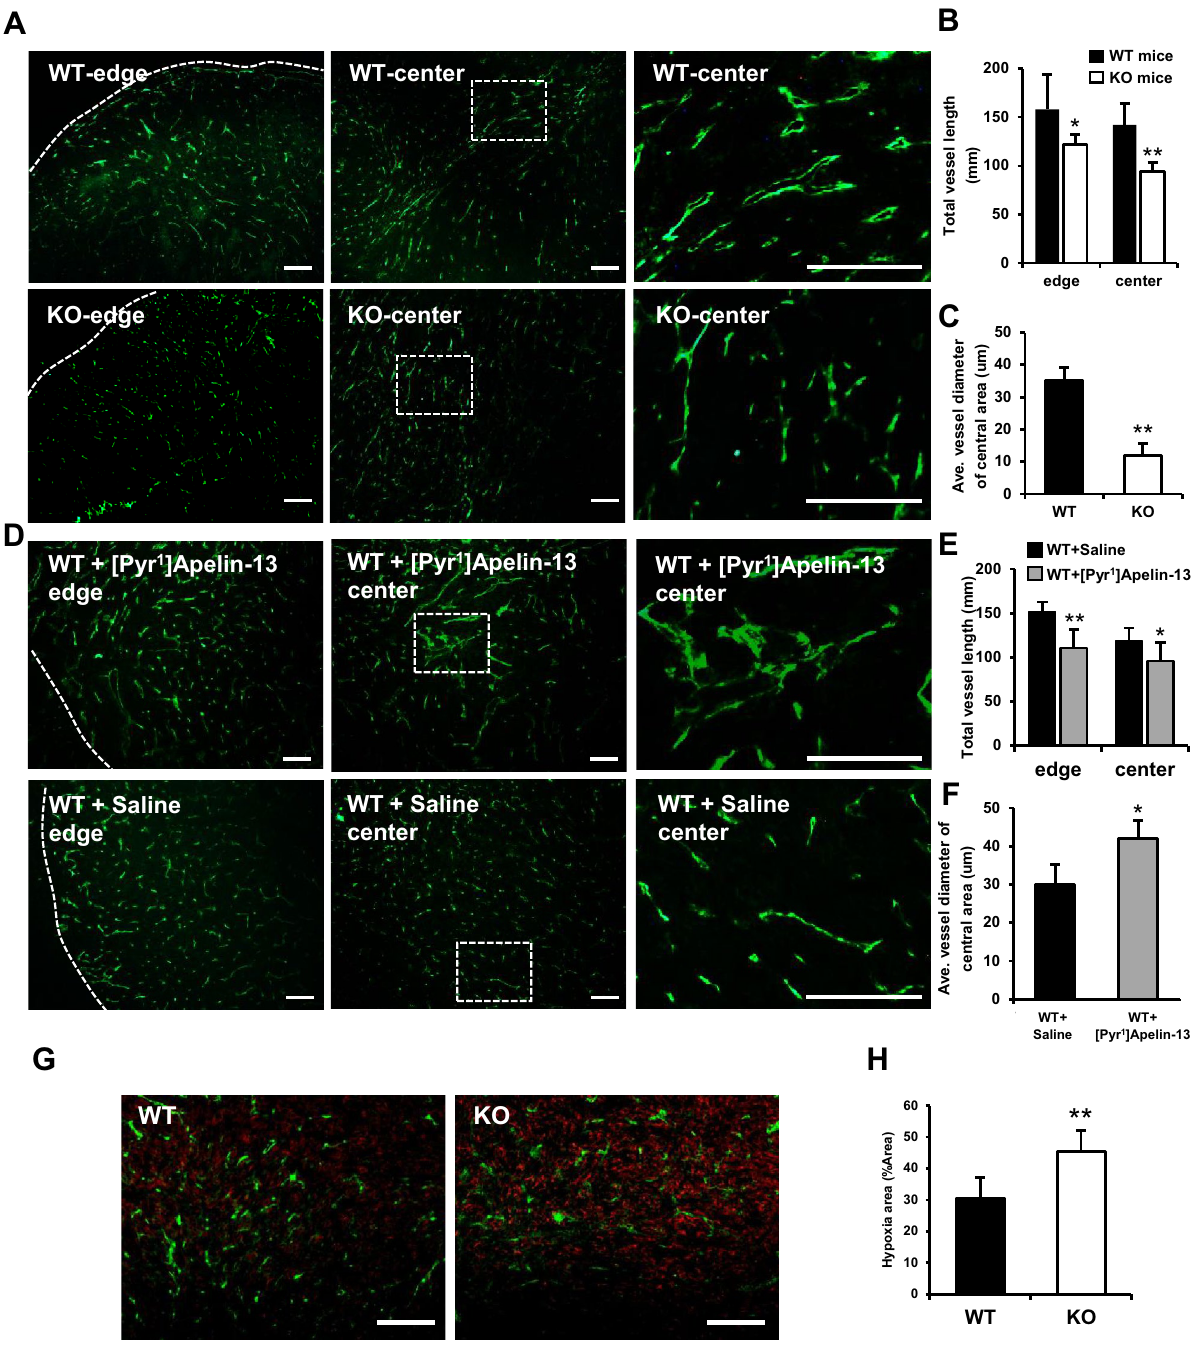
Figure 3. Tumor vessel formation and functional analysis. ( A ) Immunofluorescence staining of CD31 (green) in frozen sections of MC38 tumors from WT or Apelin-KO mice. Scale bar = 200 µm. ( B ) Quantification of total vessel length (6 random fields of 5 independent tumor sections). [edge; 158.05 ± 35.47 (WT) vs 122.14 ± 23.17 (KO), p = 0.04, center; 141.99 ± 21.99 (WT) vs 93.80 ± 13.07 (KO), p = 0.0003]. ( C ) Quantification of average vessel diameter of tumor central area (6 random fields of 5 independent tumor sections). ( D ) Immunofluorescence staining of CD31 (green) in frozen sections of MC38 tumors from WT mice receiving [Pyr 1 ]Apelin-13 or saline infusions using osmotic pumps. Scale bar = 200 µm. ( E ) Quantification of total vessel length (6 random fields of 5 independent tumor sections). [edge; 152.10 ± 10.07 (Saline) vs 110.55 ± 21.27 ([Pyr 1 ]Apelin-13), p = 0.0005, center; 118.93 ± 14.30 (Saline) vs 95.89 ± 21.04 ([Pyr 1 ]Apelin-13), p = 0.03]. ( F ) Quantification of average vessel diameter of tumor central area (6 random fields of 5 independent tumor sections). ( G ) Immunofluorescence staining of CD31 (green) in MC38 tumor sections from WT and Apelin-KO mice. Hypoxic status was revealed by Hypoxyprobe-1 (red). Scale bar = 200 µm. ( H ) Quantification of the hypoxic area in MC38 tumor sections. Data are mean ± SD and were analyzed by two-sided Student’s t-test. *p < 0.05, **p <